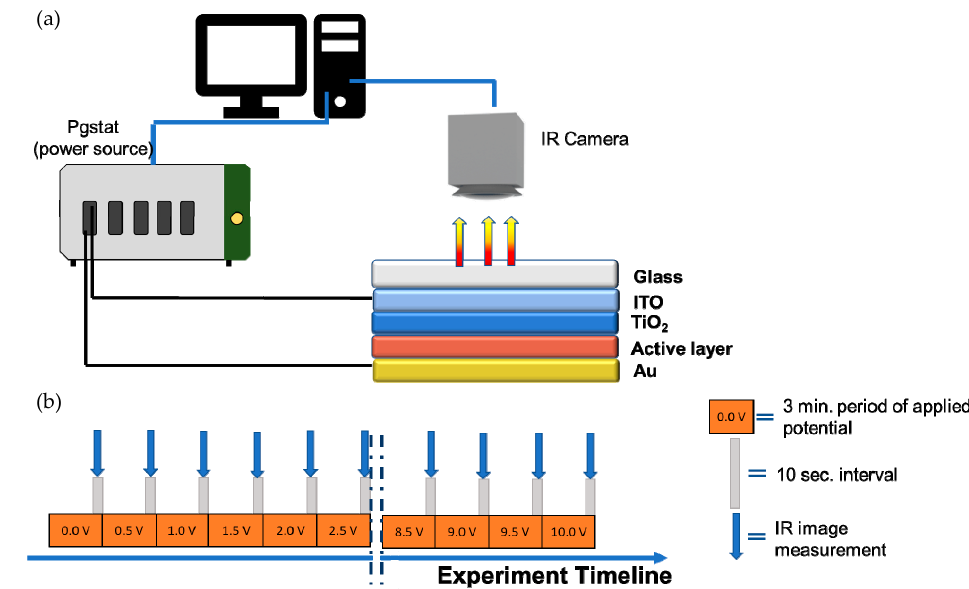
Figure 1. Thermography setup used to record images at different potentials ( a ); experimental timeline visualization presenting steps during thermographic experiment ( b ).